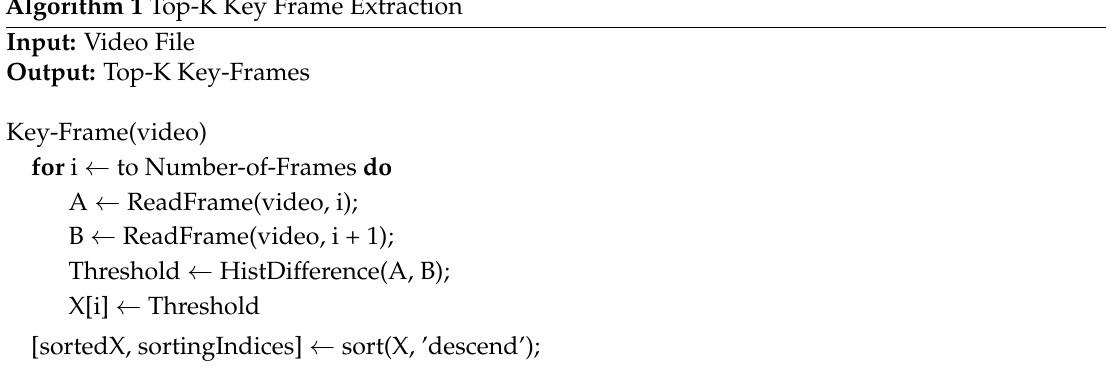
Algorithm 1 Top-K Key Frame